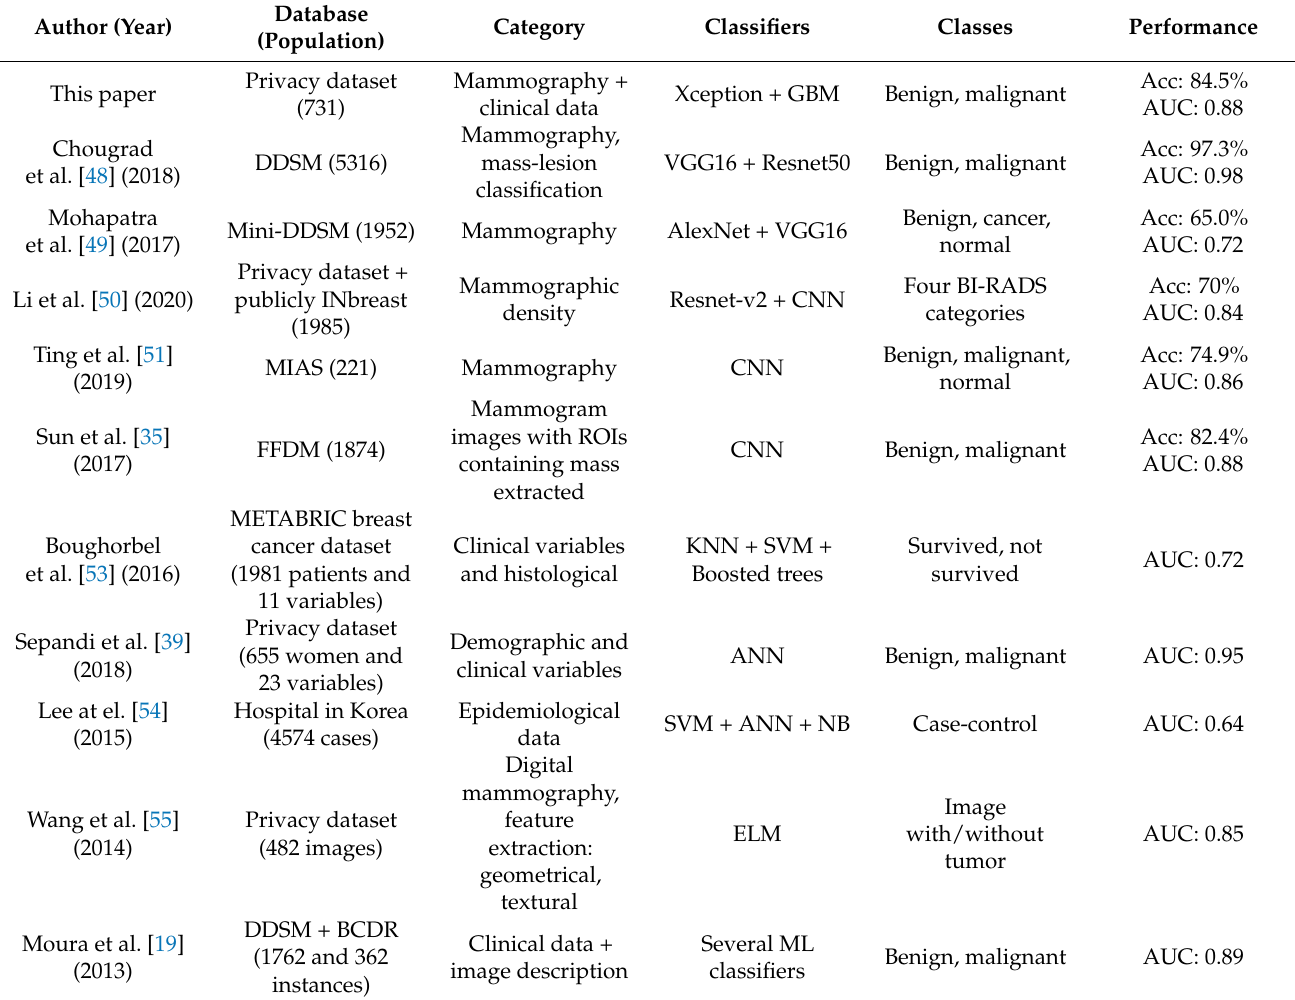
Table 6. Performance-based proposed model comparison with existing best-practice